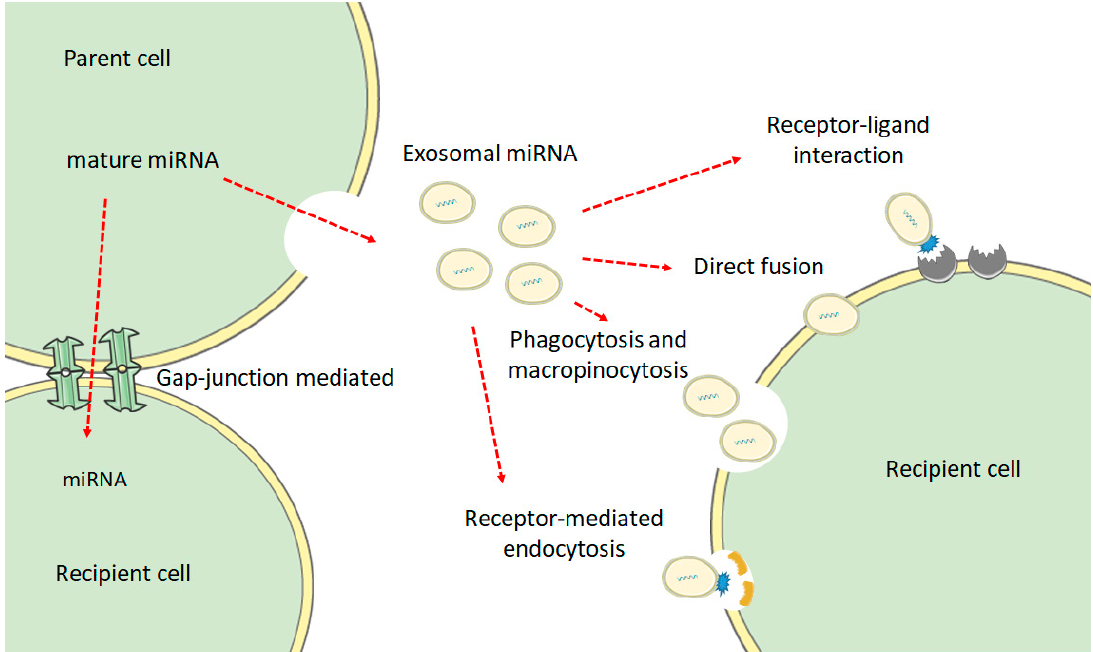
Figure 3 . Proposed mechanisms of exosomal microRNA delivery into the target cell. Figure 3. Proposed mechanisms of exosomal microRNA delivery into the target